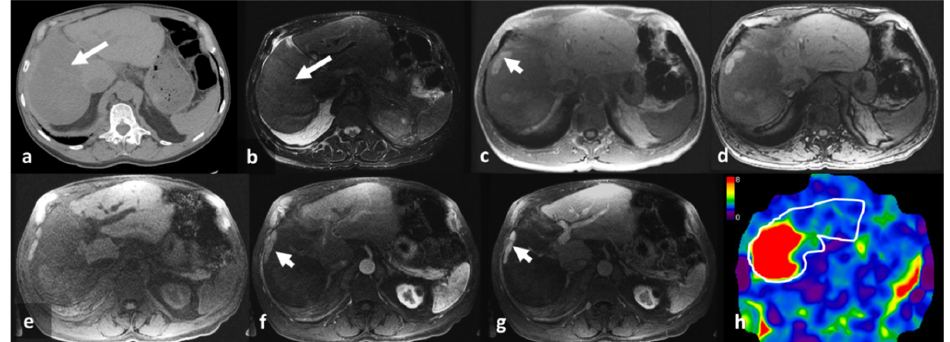
Figure 3. A 68-year-old male with known systemic amyloidosis and post autologous stem cell transplant on follow up. The axial non-contrast enhanced CT image ( a ) shows hypodense in the right lobe (arrow). The axial T2-weighted image ( b ) shows hyperintensity in the right lobe corresponding to the hypodensity in that lobe. In-phase ( c ) and opposed-phase ( d ) images show no significant signal loss (<5%) in the right lobe, confirming that there is no increase in fat. Note the small subcapsular area of sparing in the right lobe (arrowhead, ( c )). The non-contrast enhanced ( e ), arterial phase ( f ), and portal venous phase ( g ) images show no significant enhancement in the right lobe but do show normal enhancement in the left lobe. The subcapsular focal area in the right lobe (arrow heads) shows similar enhancement to the left lobe, suggesting a spared region of normal liver parenchyma. The MRE stiffness map with a scale of 0–8 kPa ( h ) shows increased stiffness in the right lobe, corresponding to the abnormality seen on CT and magnetic resonance imaging (MRI), and normal stiffness in the left lobe. The mean ± SD LSM is 6.7 ± 1.2 kPa.